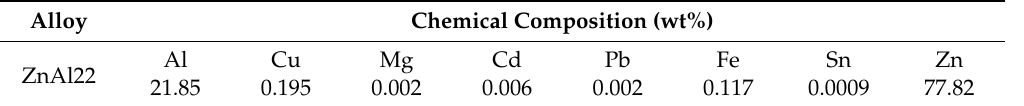
Table 1. Chemical composition (wt%) of the Zn–Al alloy investigated. Alloy Chemical Composition (wt%) ZnAl22